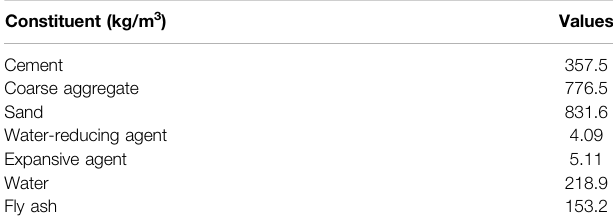
TABLE 2 | Composition of self-compacting